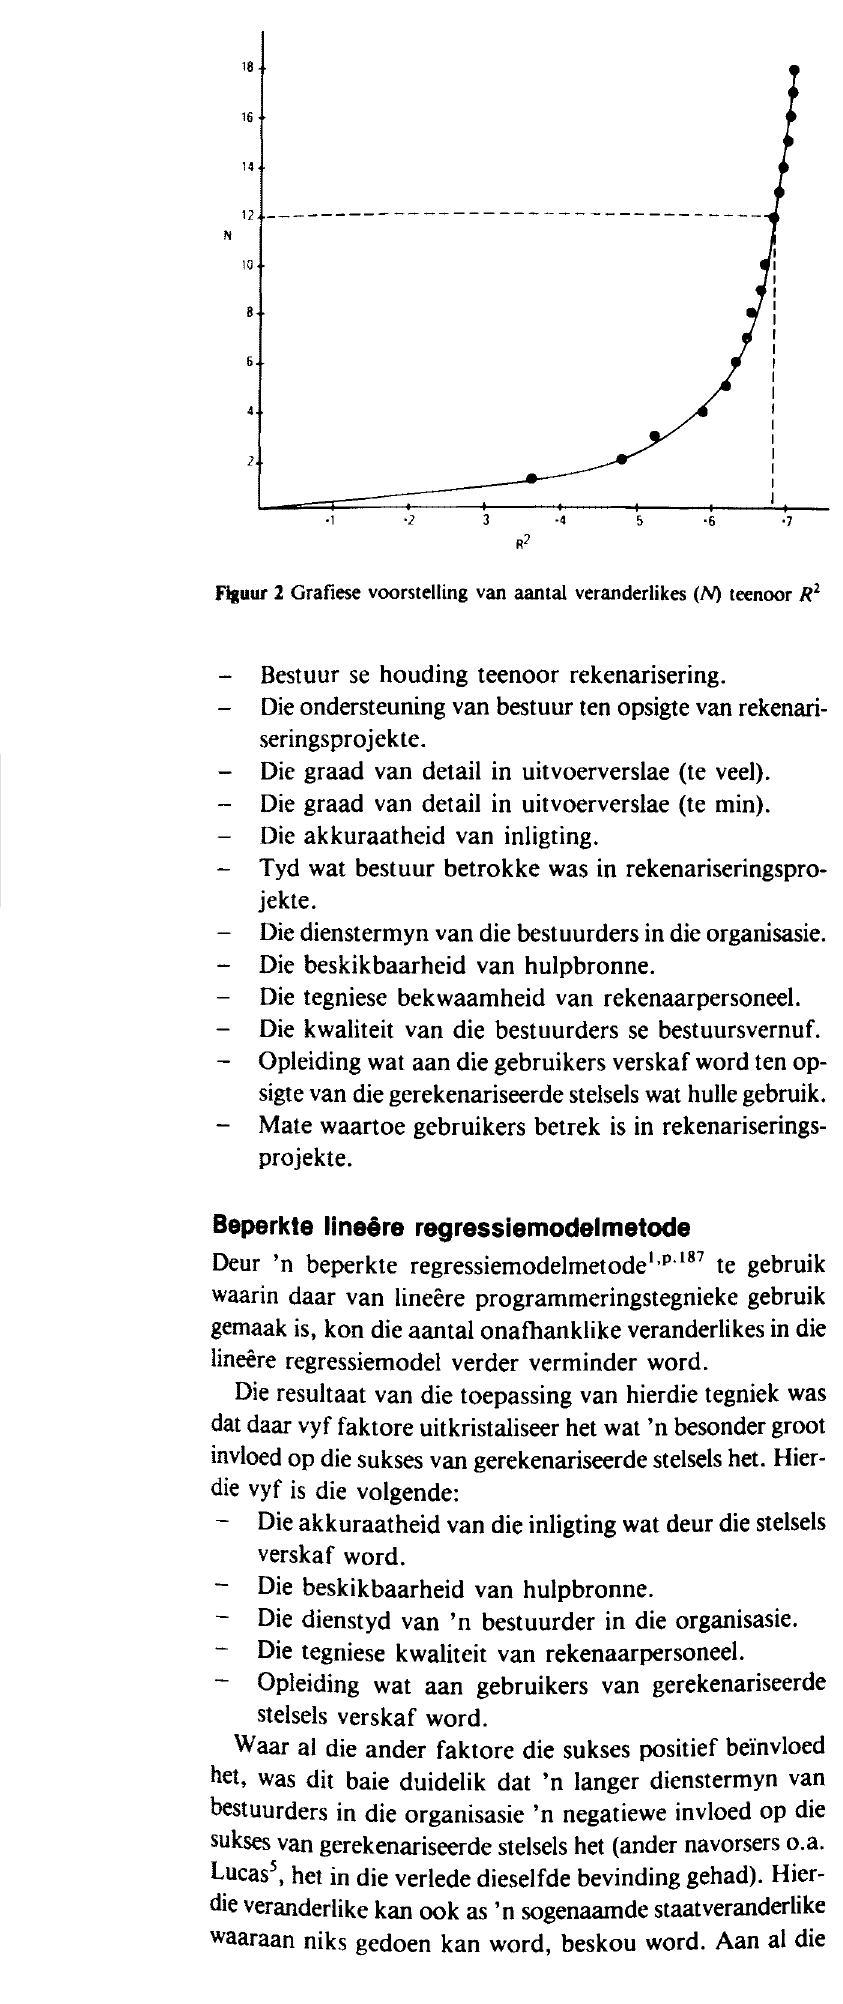
fl&uur 2 Grafiese voorstelling van aantal veranderlikes (N) teenoor R 2